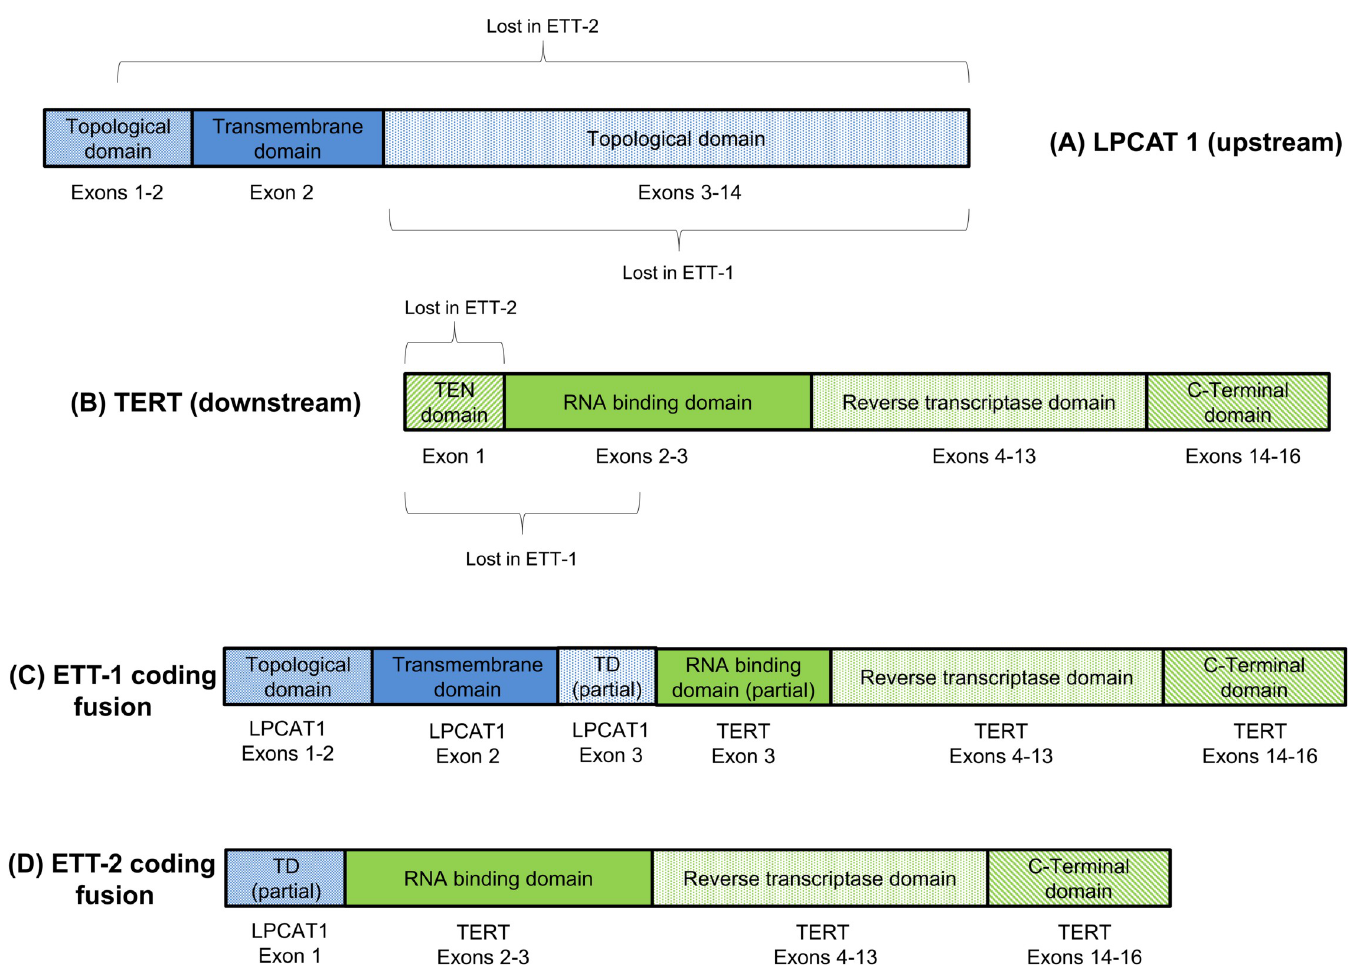
Fig 3. Predicted preserved protein domains for the in-frame LPCAT1-TERT fusions in ETT-1 and ETT-2. (A) Native LPCAT1 (upstream of TERT), and (B) TERT (downstream of LPCAT1) domains are illustrated in upper image, with the regions predicted to be lost in the fused products indicated by labeled brackets. Putative fusion proteins (C, D) are shown in the lower image. In each fusion, TERT lacks components (TEN domain and partial/whole RNA binding domain) believed critical for normal telomerase function. The LPCAT1 topological domain (TD) retained in ETT-1 and partially retained in ETT-2 is cytoplasmic in nature while the transmembrane domain retained in ETT-1 only is helical. A fragment of the larger (lumenal) LPCAT1 topological domain is retained in ETT-1 and lost in ETT-2. Regions are not drawn to scale.